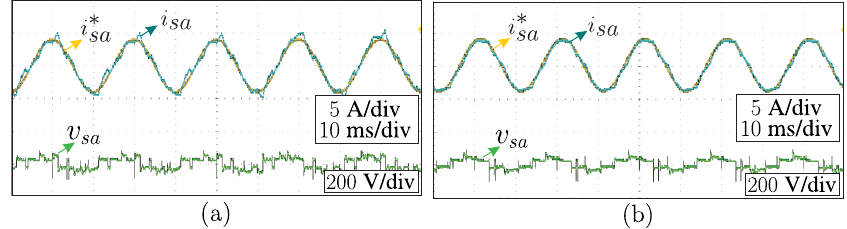
Figure 11. Experimental results of designed algorithms: ( a ) Classic SMC. ( b )